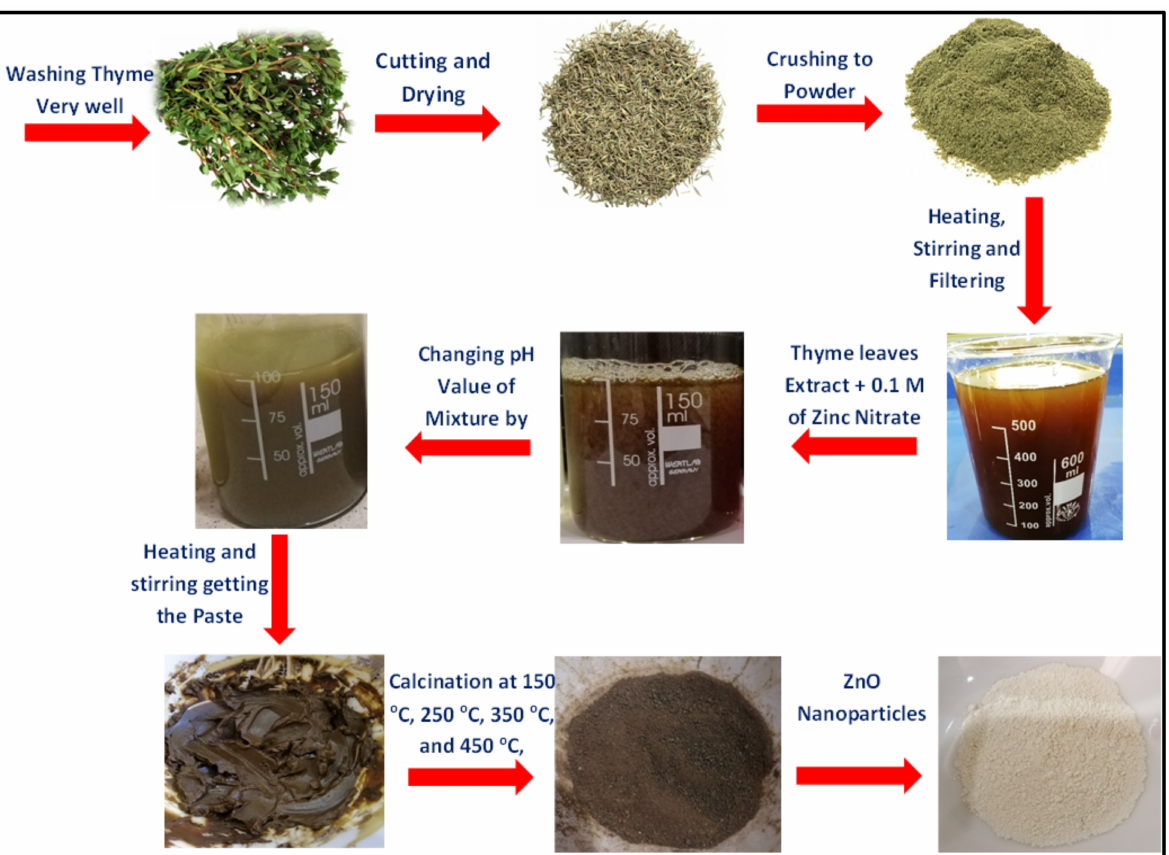
Figure 1. Schematic representation of green synthesis process of ZnO NPs by using the leaf extract of thyme plant and zinc nitrate